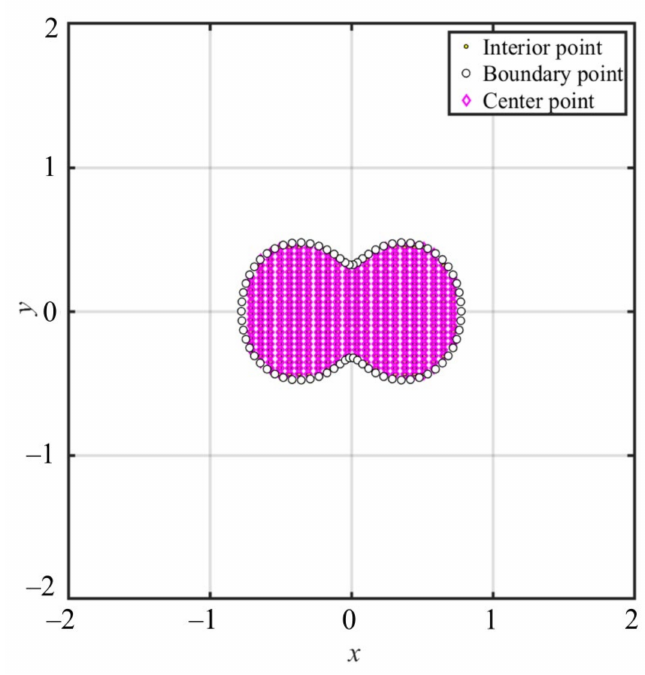
Figure 13. The conventional RBFCM collocation scheme.